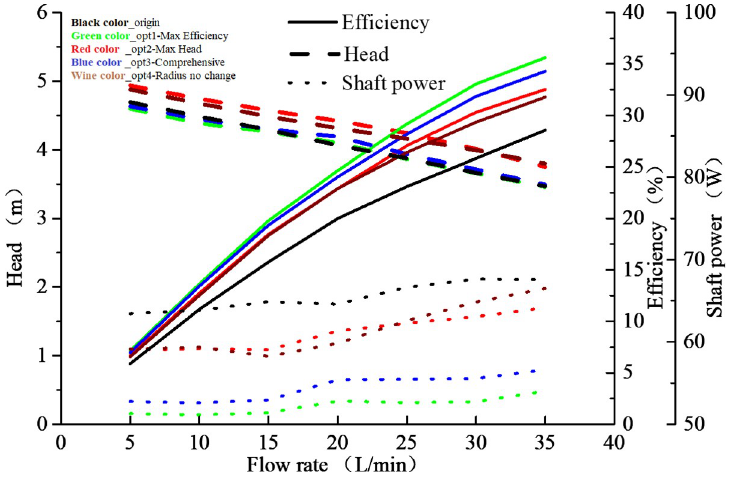
Fig 8. Hydraulic performance curves.